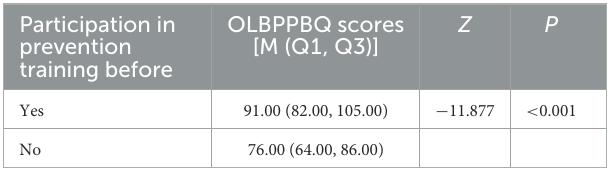
TABLE 5 Between-group differences in OLBPPBQ scores of nurses with a history of occupational low back